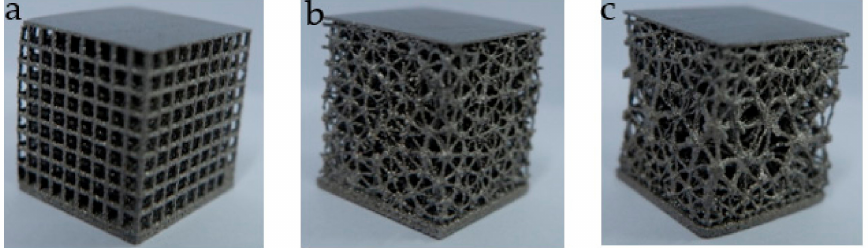
Figure 28. Ti6Al4V structures made by EDM. ( a ) Regular porous structure; ( b ) Irregular porous structure; ( c ) Gradient irregular porous